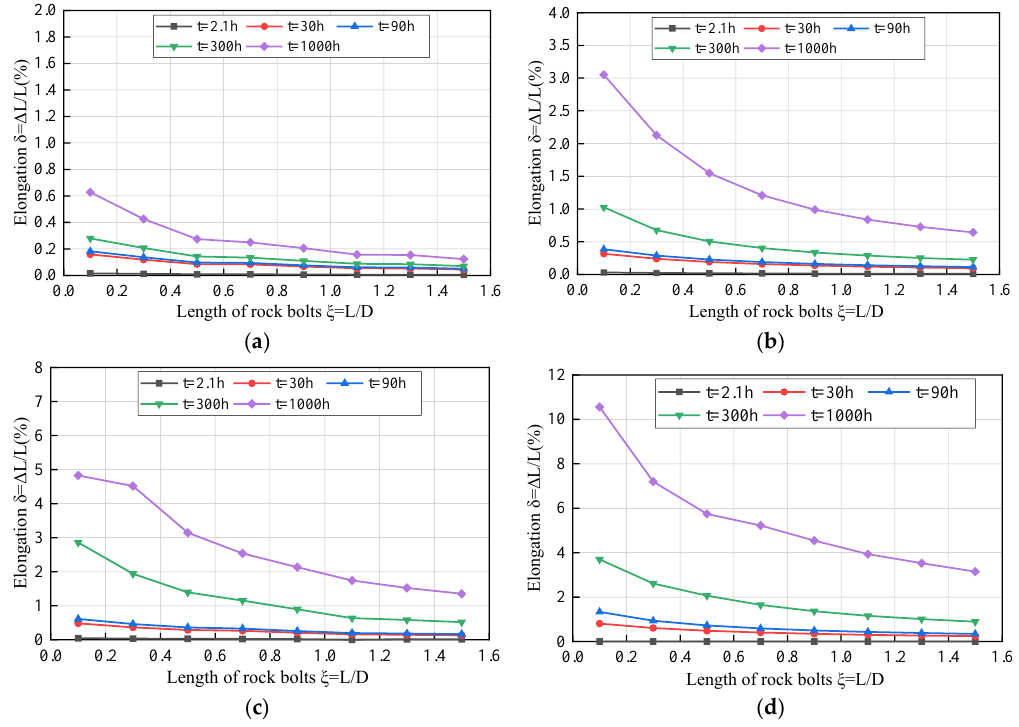
Figure 7. Elongation at different times after the tunnel excavation: ( a ) β = 0.8 (Class A); ( b ) β = 0.4 (Class B); ( c ) β = 0.26 (Class C); ( d ) β = 0.16 (Class